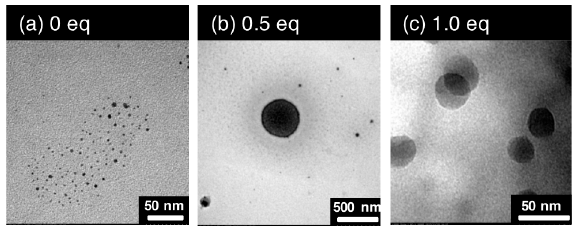
Figure 9. TEM images of the Pt nanoparticles obtained by NaBH 4 reduction of [( 3 )( β -CD)](NO 3 ) 3 in an aqueous solution (3.0 mM): ( a ) as prepared, ( b ) after addition of tetrakis(4-carboxyphenyl)porphyrin (TCPP) (0.5 eq to Pt), ( c ) after further addition of TCPP (1.0 eq to Pt).